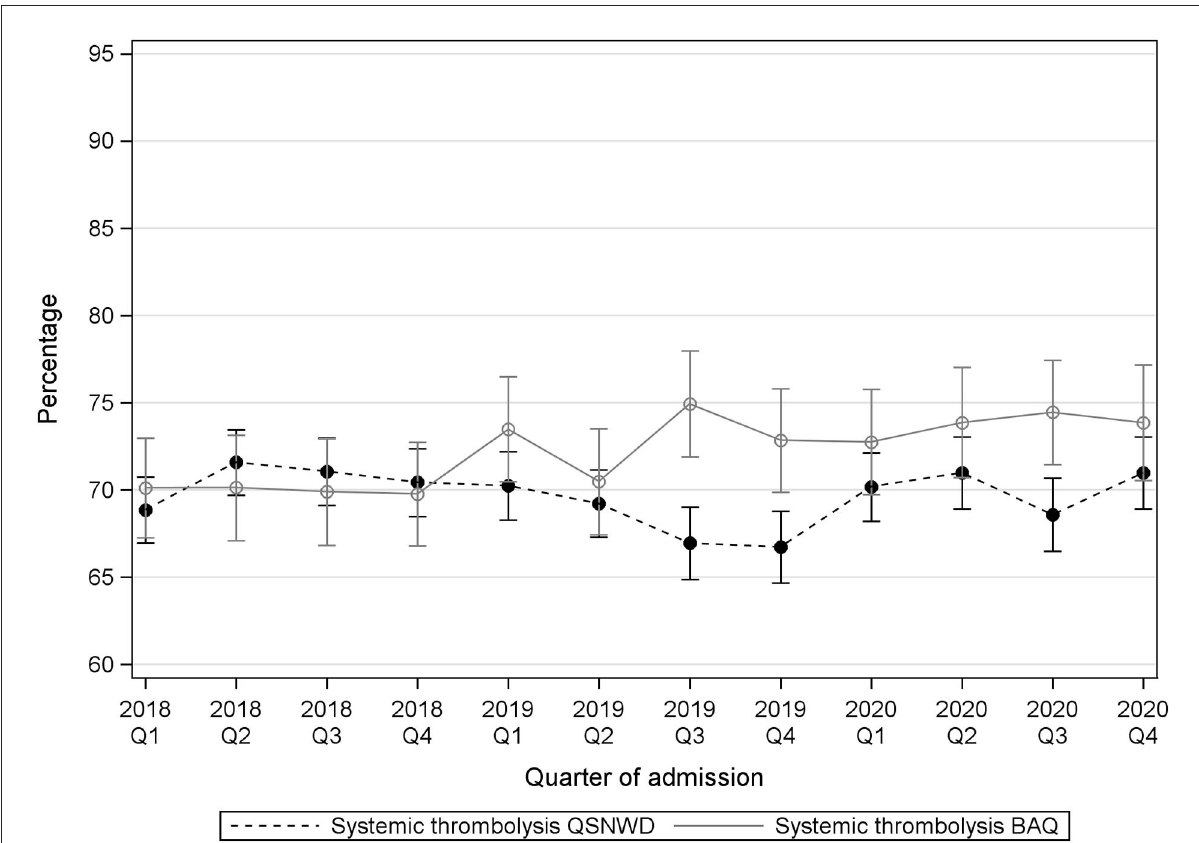
FIGURE2 Systemic thrombolysis in patients with cerebral infarction, a time interval event to admission of ≤ 4h, a NIHSS 4–25 and 18–80 years old from the registries QSNWD (dashed line) and BAQ (solid line) in 2018-2020 by quarter of